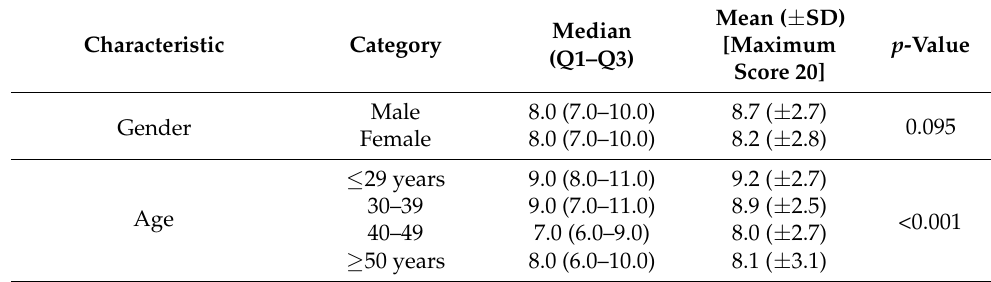
Table 5. The association between the overall knowledge score about drug–dietary supplement and drug–herbal product interactions, and respondent’s general